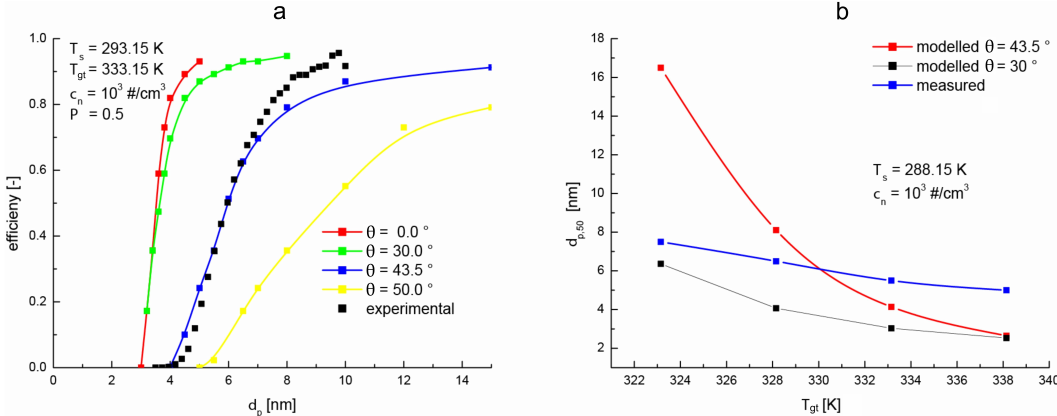
Fig. 3. CPC counting efficiency as a function of particle diameter (a) and cut-off diameter as function of growth tube temperature (b)